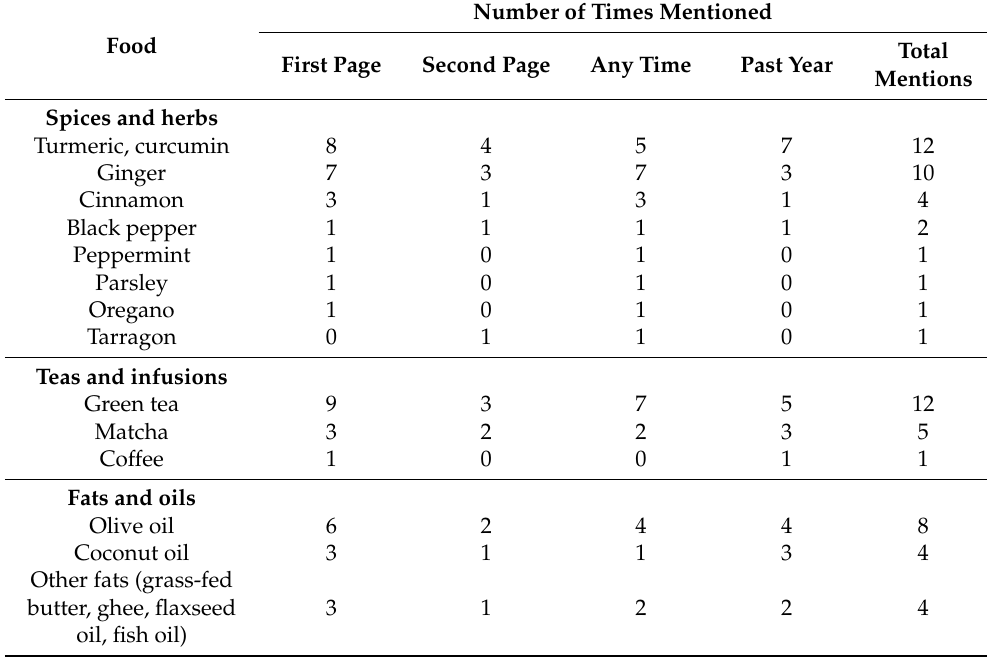
Table 7. Classification of spices and herbs, teas and infusions, and fats and oils by the number of times that were mentioned on selected web